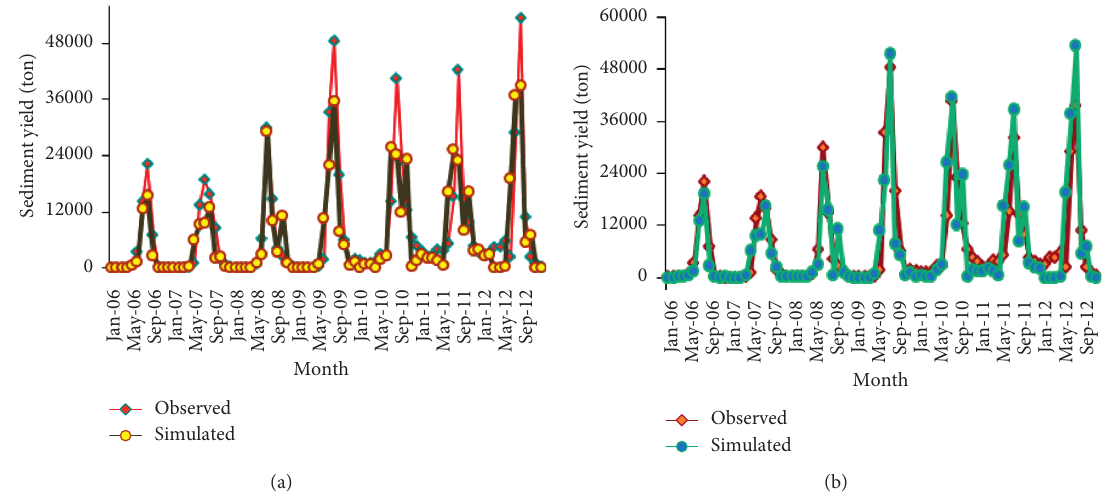
Figure 16: Sediment flow comparison for calibration periods (a) 1998 LULC and (b) 2016 LULC.